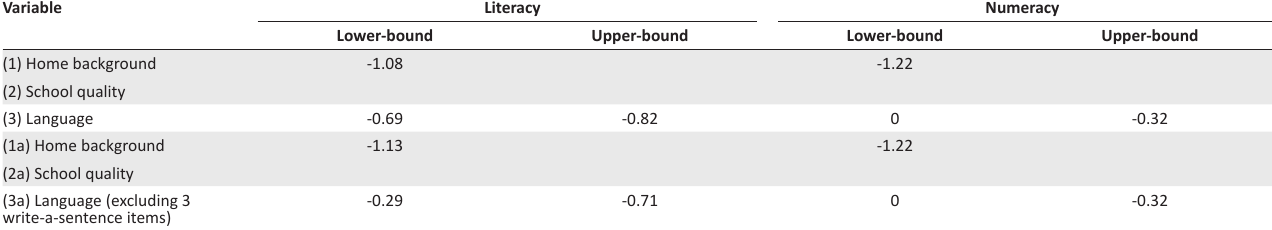
TABLE 11: Size of various ‘effects’ in standard deviations for students whose home language is not English.